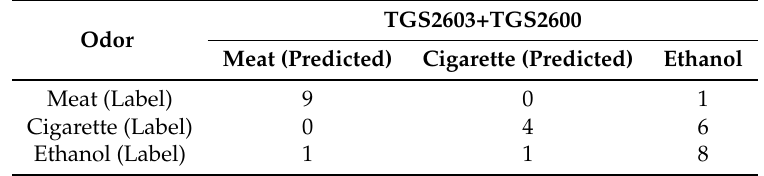
Table 5. Confusion matrix in an open